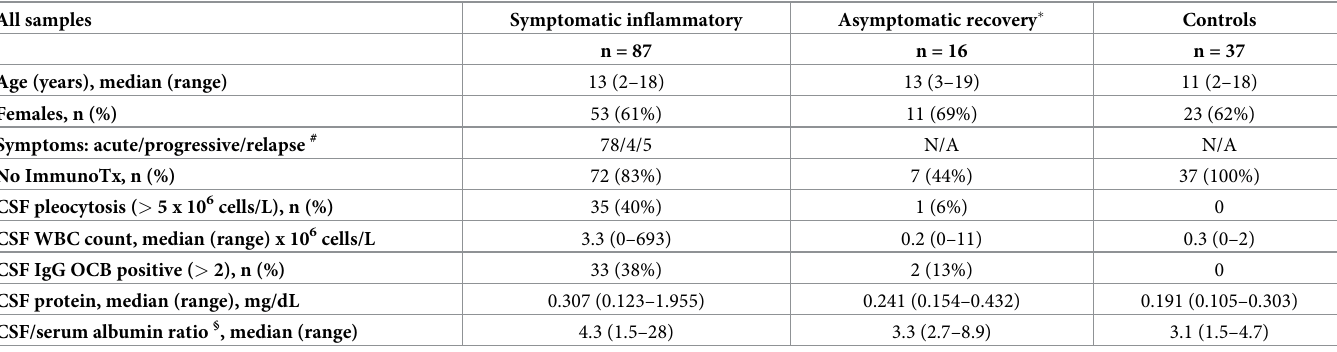
Table 1. Clinical and laboratory characteristics of the